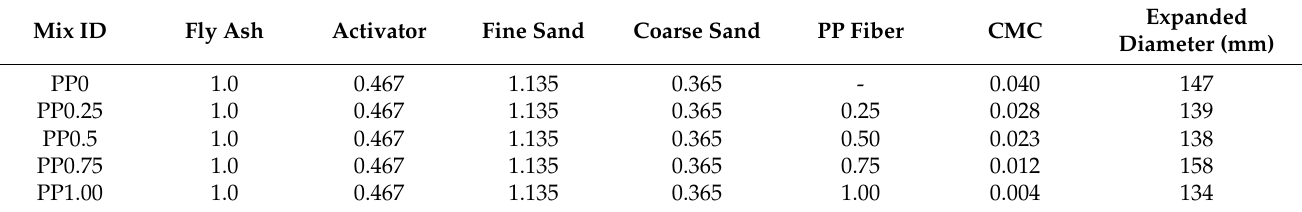
Table 3. The mix proportions of 3D-printed geopolymer